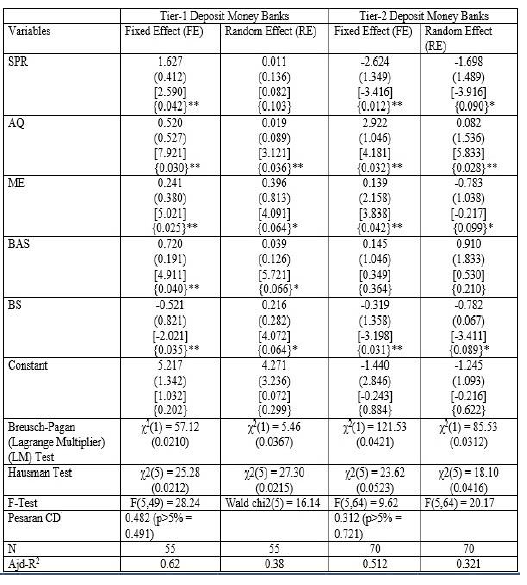
Dependent Variable: Capital Adequacy Ratio (Bank